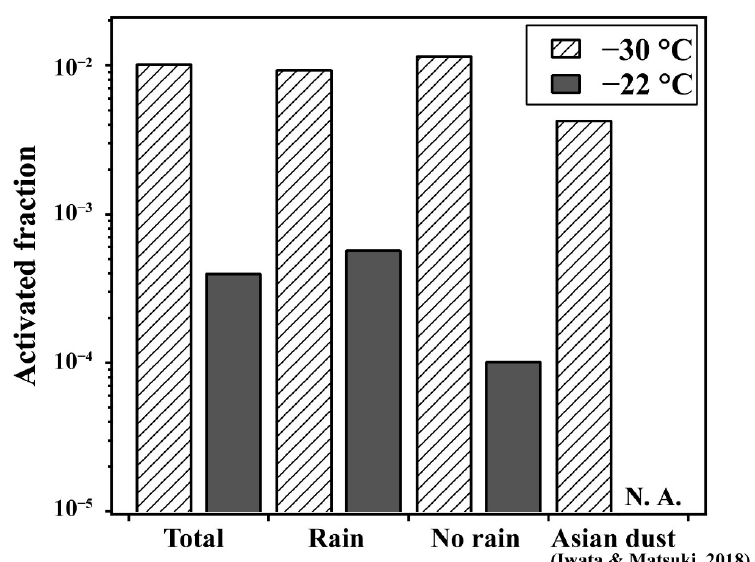
Figure 1. Ice nucleation (IN) activated fractions of samples with rain and without rain. These fractions yield the ratio of ice-nucleating particles (INPs) identified at respective temperatures (striped bar: − 30 ◦ C, solid bar: − 22 ◦ C) relative to the total number of particles observed by the individual droplet freezing method (IDFM).